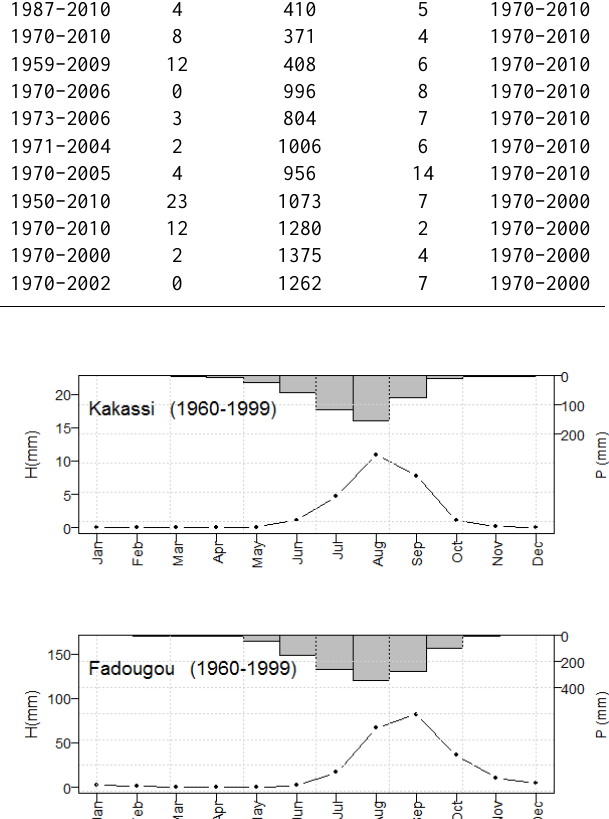
Figure 1. Location of the 11 West African catchments used for this study; the isohyets were created from climatic research unit (CRU) spatial rainfall data from 1960 to 1990.